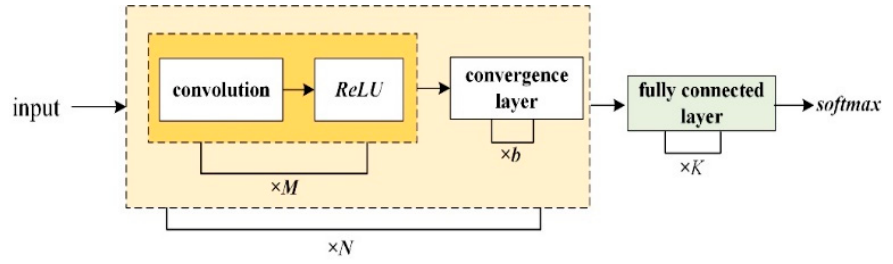
Figure 2. Structure of the ordinary convolutional network.